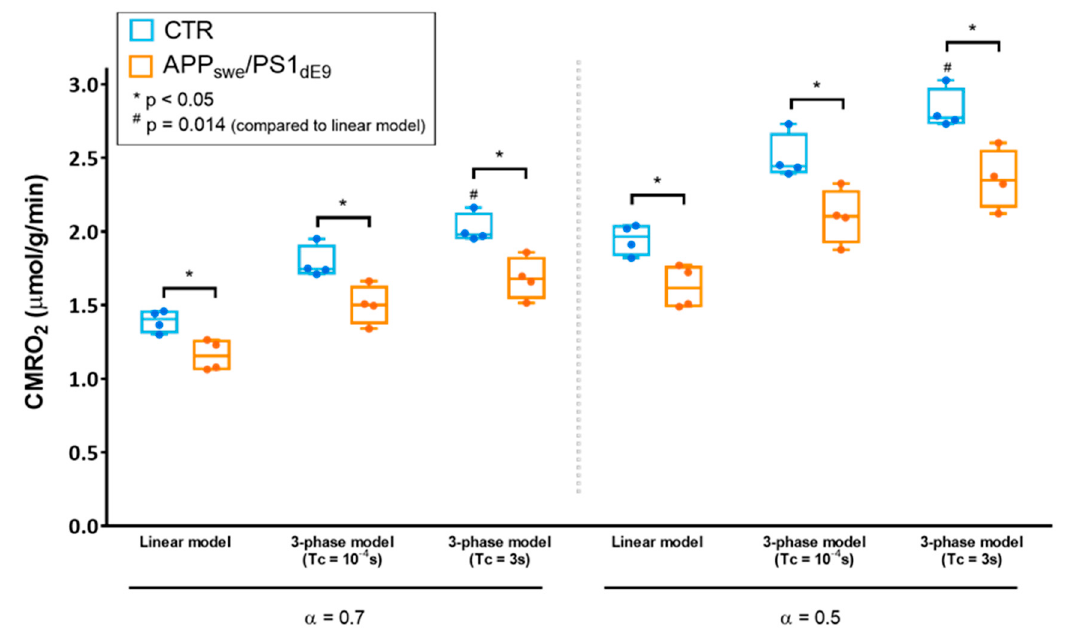
Figure 3. Effect of the choice of the model on CMRO 2 quantification and group comparison. CMRO 2 quantified with different models (linear model or 3-phase model) and different sets of parameters (enrichment fraction α = 0.7 or 0.5, blood circulation time Tc → 0 (Tc = 10 − 4 s or Tc = 3 s) are displayed for CTR (in blue) and APP swe /PS1 dE9 (in orange) as min-to-max box and whiskers plots. The grey dotted line separates quantifications ran assuming a 17 O enrichment fraction of 70 % ( α = 0.7) (left side) and 50% ( α = 0.5) (right side), thereby accounting for possible contamination of the inhaled mixture with ambient 16 O 2 within the nose cone. * indicates significant differences between CTR and APP swe /PS1 dE9 with p < 0.05 using a Mann-Whitney’s U test. # indicates significant differences compared to the results from the linear model using a Friedman test followed by Dunn’s multiple comparison test ( p = 0.014).